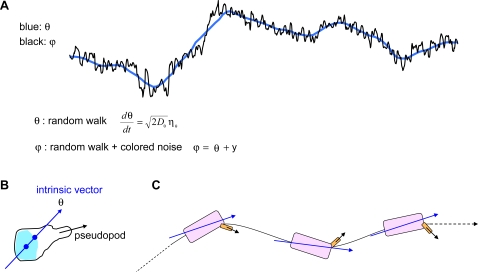
A model for Dictyostelium motion.(A) The blue line is hand drawn to guide the eye and represents θ, a one-dimensional random walk. The black line ϕ, is an enlarged view of the data in box 3 of Fig. 6. In our model, ϕ is the net effect of θ and colored noise centered on θ. The stochastic differential equations used to describe the behavior of ϕ and θ are explained in detail in the text. (B) θ is the angle assumed to be fixed by a cell's intrinsic polarity, possibly a vector directed from the center of nucleus (light blue) to the position of the centrosome [19]. Black arrow, pseudopod extensions and retractions lead to stochastic oscillations. New pseudopods bifurcate from old, and they swing back and forth about the internal vector. (C) A cartoon describing directional control.